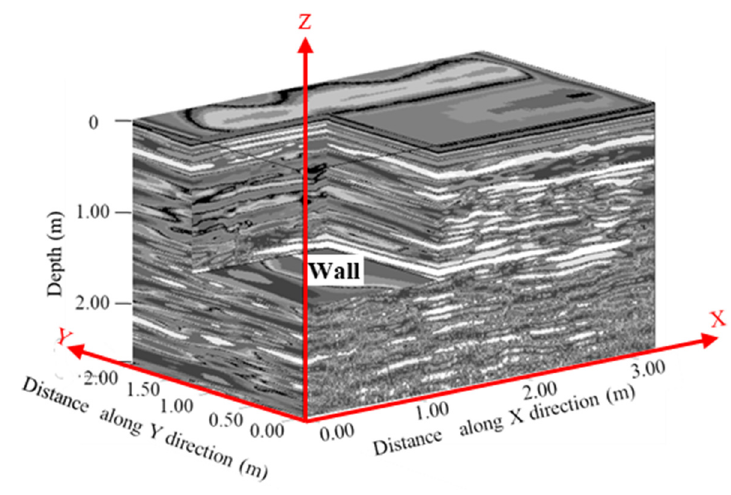
Figure 19. The 3D section (cut-out cube) using X = 1.3 m, Y = 1.5 m, and Z = 1.5 m.